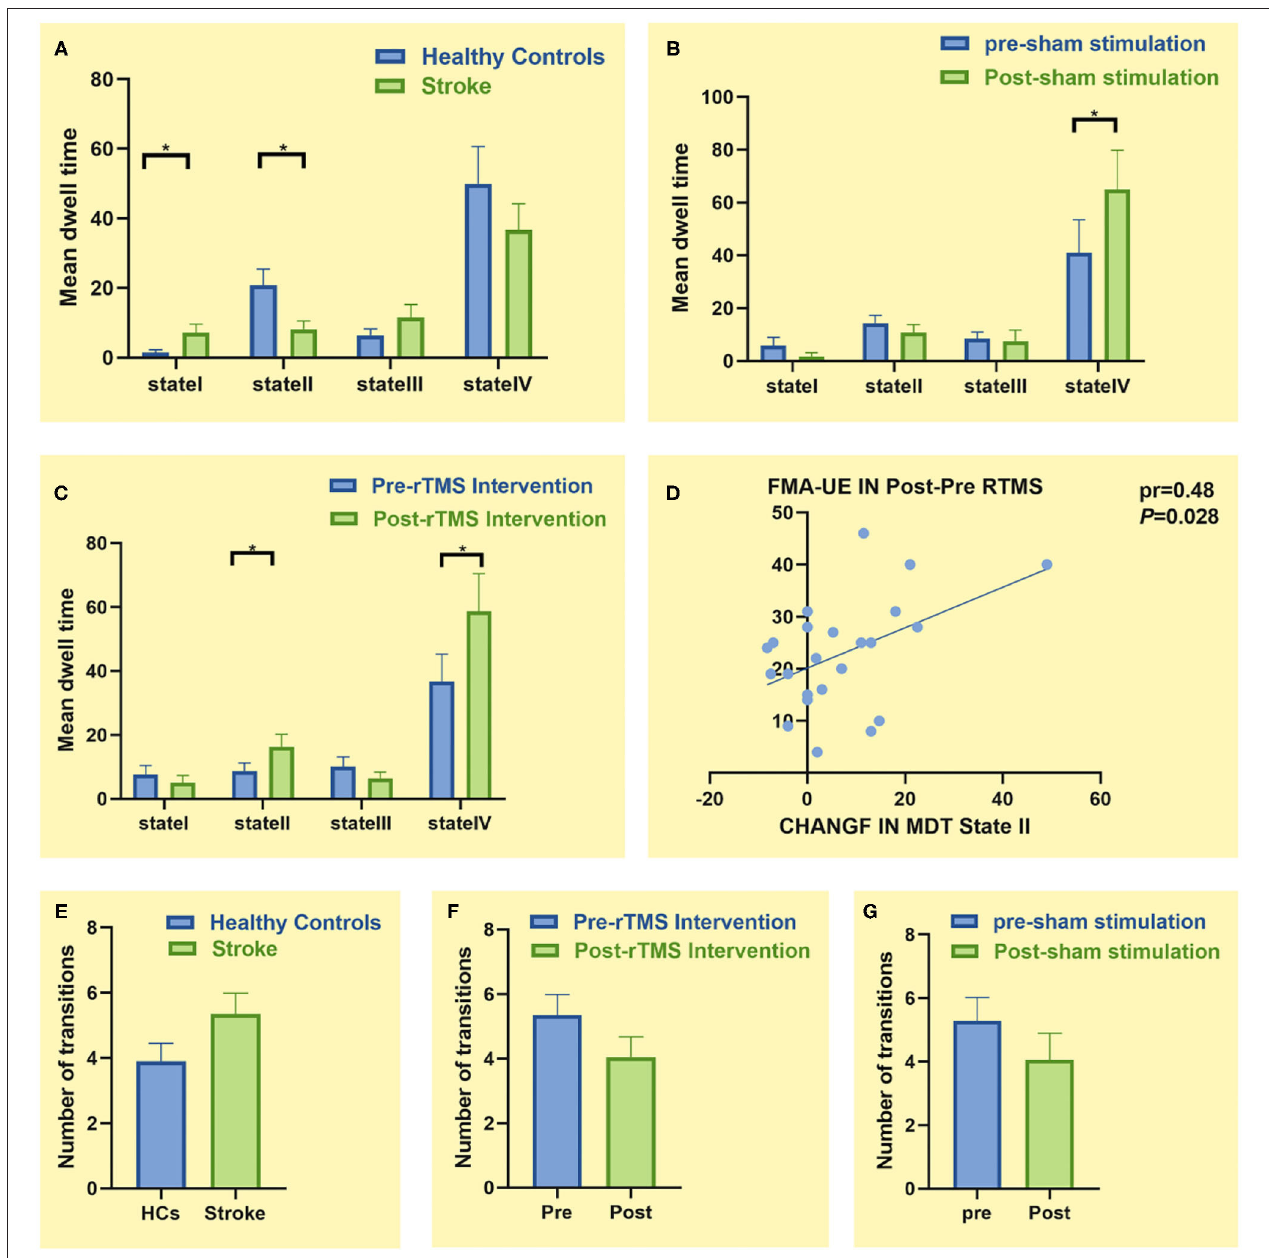
FIGURE 5 | Comparison of temporal characteristics of functional connectivity states between groups. (A) Comparison of mean dwell time (MDT) between healthy controls ( n = 20) and patients with stroke ( n = 23). (B) Comparison of MDT before and after sham stimulation ( n = 18). (C) Comparison of MDT before and after low-frequency repetitive transcranial magnetic stimulation (LF-rTMS) treatment ( n = 23). (D) Correlation between change in the Fugl–Meyer Assessment for Upper Extremity (FMA-UE) score and change in MDT of state II. (E) Comparison of number of transitions between healthy controls ( n = 20) and patients with stroke ( n = 23). (F) Comparison of number of transitions before and after LF-rTMS treatment ( n = 23). (G) Comparison of number of transitions before and after sham stimulation ( n = 18). * p <